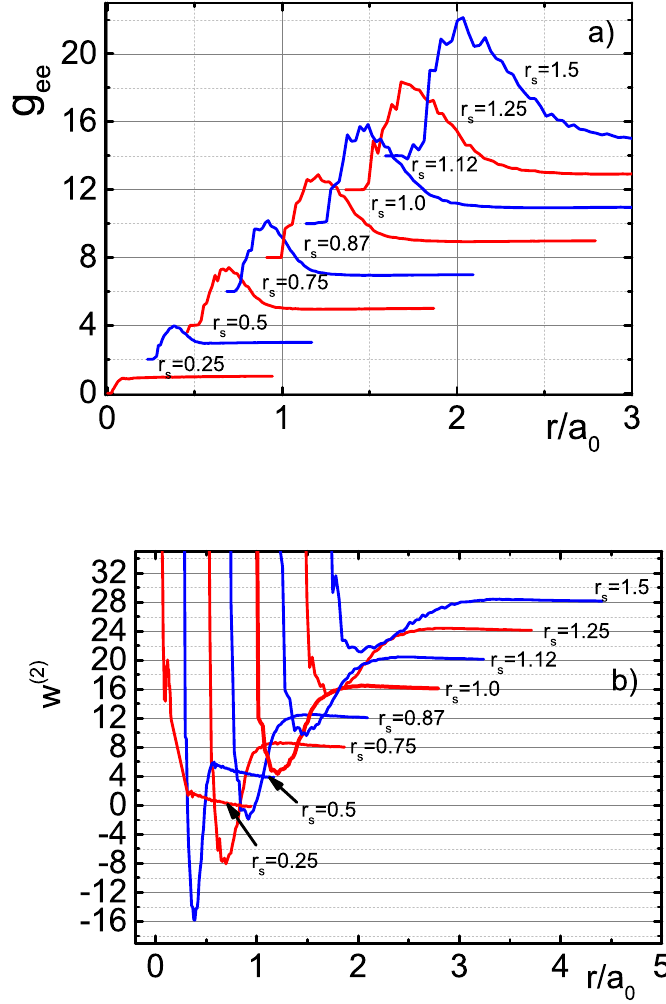
Figure 2. (Color online) ( a ) The UEG electron PDFs g ee ( | r | / a 0 ) and ( b ) the potential of mean force w ( 2 ) ( r / a 0 ) at Θ = 4; g ep and g pp in the considered UEG model are identically equal to unity. For r s = 0.5 − B = − 0.38; for r s = 0.75 − B = 2.2; for r s = 0.87 − B = 0.97; for r s = 1 − B = 6.11; for r s = 1.12 – B = 6.15; for r s = 1.25 − B = 7.5; for r s = 1.5 − B = 7.82. The positive or negative values of B are obtained from the criterion of bound states existence